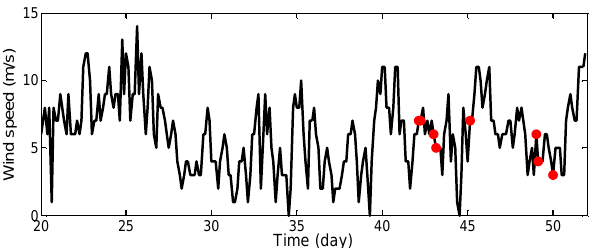
Figure 12. Significant wave heights (solid line) and maximum wave heights (dotted line) for 20- Figure 10. Wind speed for 20 June-21 July 2008 in Kalbadagrund (Finland); the circles show the Fig. 12. Significant wave heights (solid line) and maximum wave Fig. 10. Wind speed for 20 June–21 July 2008 in Kalbadagrund minute intervals of the night data from 22 June-21 July 2008; the circles show the times when times when freak waves of the Group II occurred. heights (dotted line) for 20-min intervals of the night data from (Finland); the circles show the times when freak waves of the freak waves of the Group II occurred. 22 June–21 July 2008; the circles show the times when freak waves Group II occurred. of the Group II occurred.